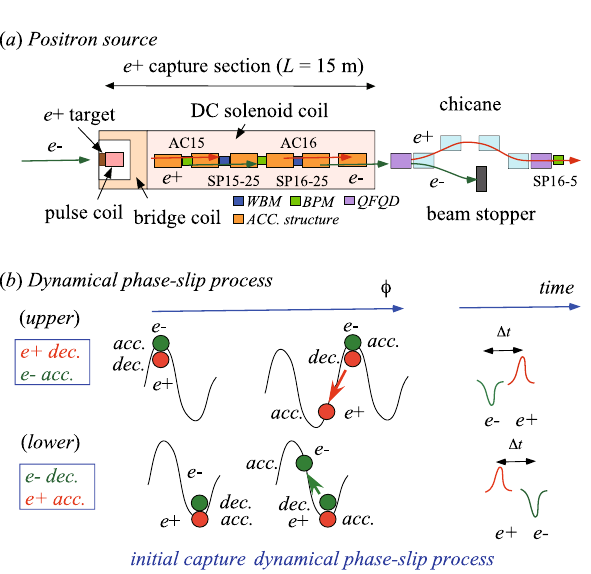
Figure 4. Three-dimensional (3D) plots for the e − and e + ( a ) first and ( b ) second main bunches as functions of the phase (cid:31) 15 and time at SP15-25. Note that the e − and e + main bunches are shown with the corresponding negative and positive output voltages, respectively. The reference time is given by the arriving time of the e − main bunch at SP15-25.